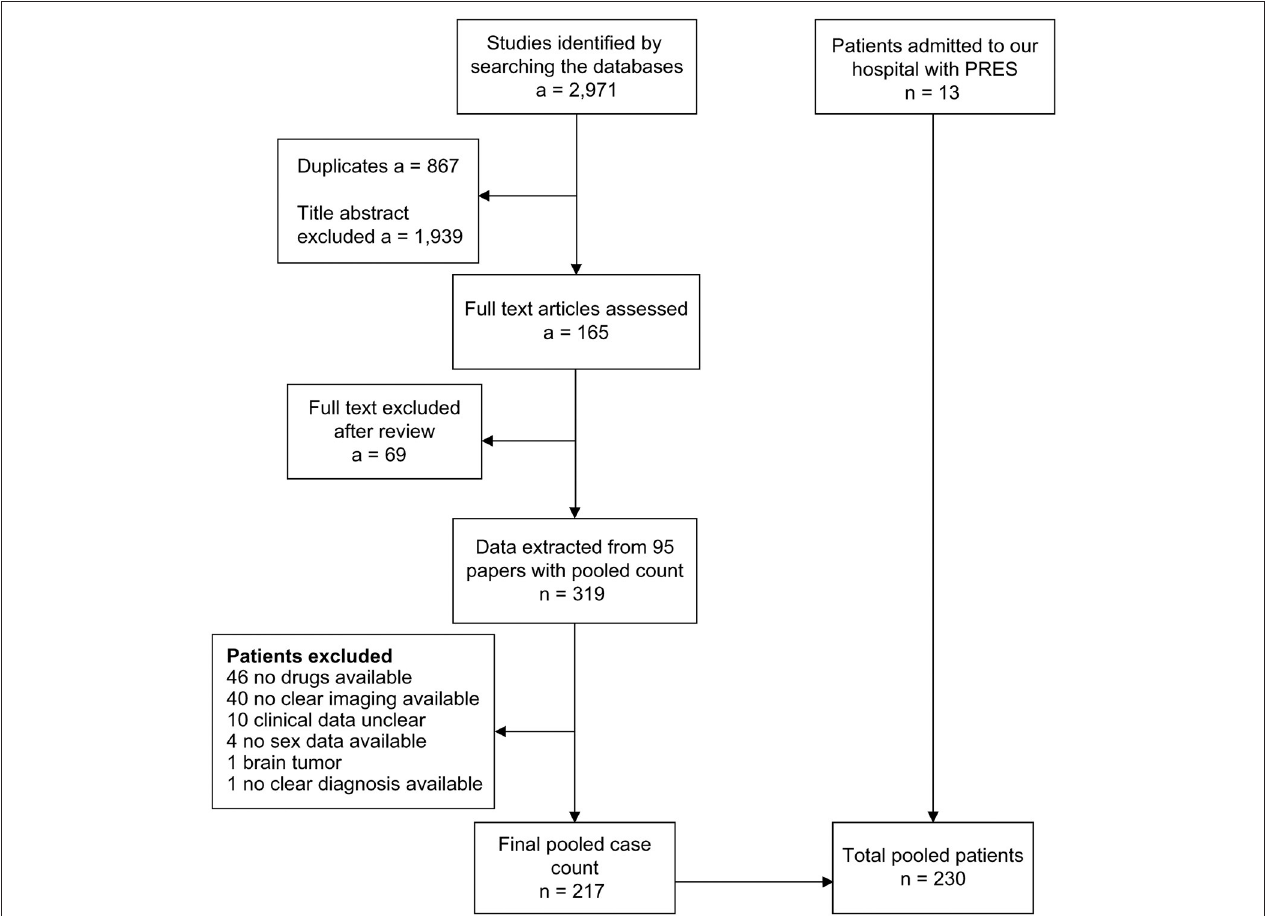
FIGURE 1 | Flowchart for patient selection. a, number of articles; n, number of patients; PRES, posterior reversible encephalopathy syndrome.